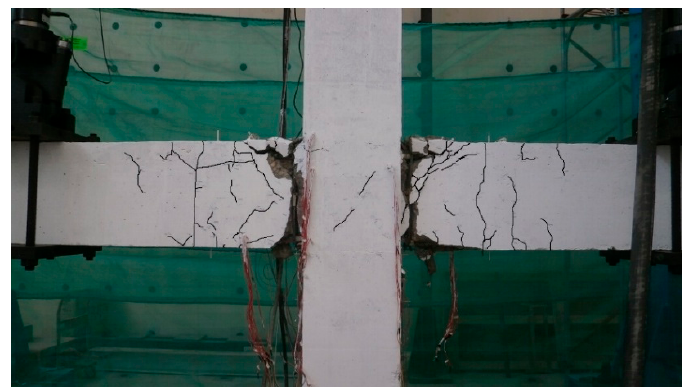
Figure 14. Distribution of cracks on the beam after yielding of the PPCJ2 joint.